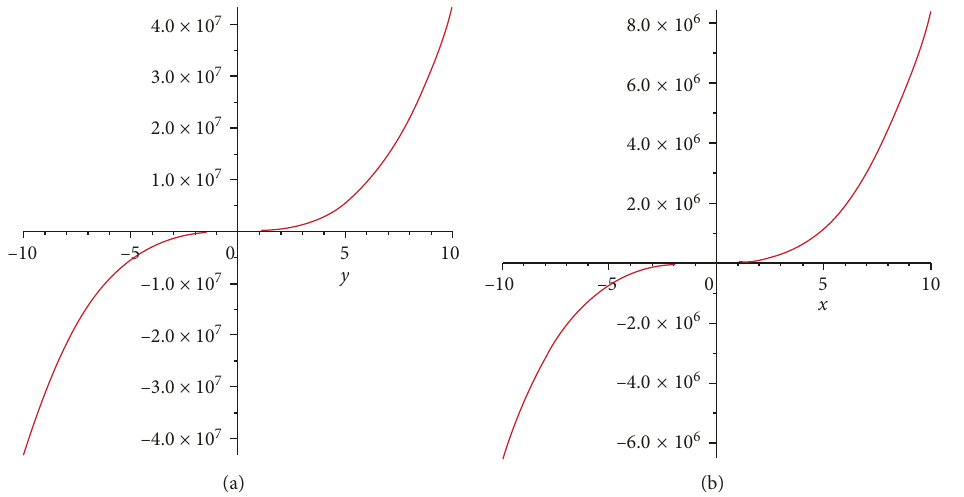
Figure 3: (a) The 2D plot of M-polynomial of the benzene ring embedded in the P-type surface network by fixing the parameter x . (b) The 2D plot of M-polynomial of the benzene ring embedded in the P-type surface network by fixing the parameter y